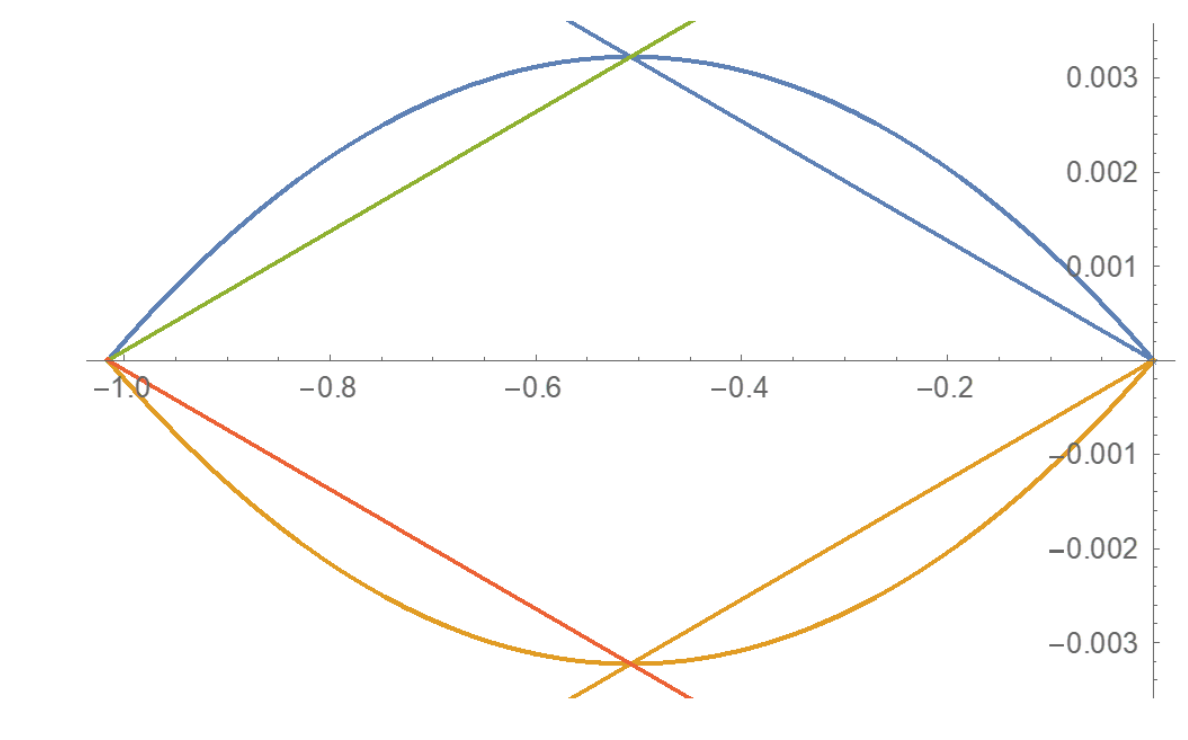
Figure 5. Linearization of the limit domain; blue, orange lines correspond to the sign of Equation